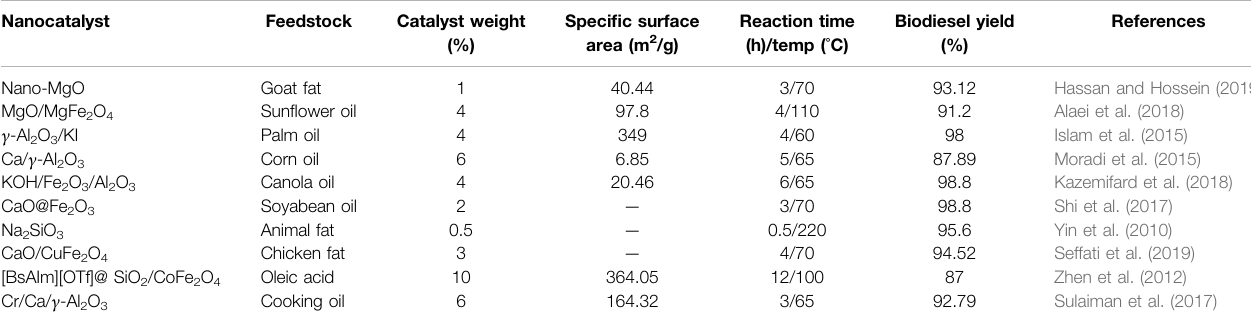
TABLE 4 | Summary of the increased biodiesel production via metal oxide based nanocatalyst.